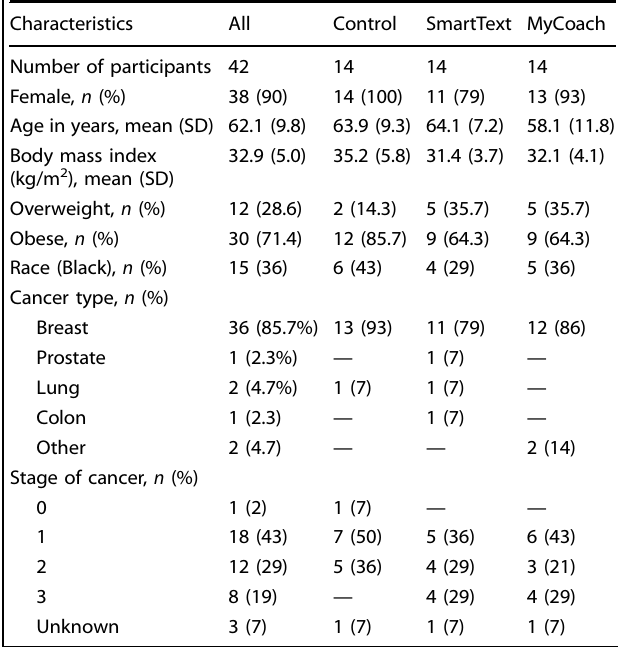
Table 1. Characteristics of the study participants by randomization